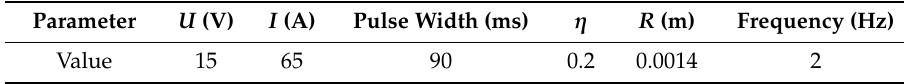
Table 6. Parameter values of the double ellipsoid heat source.